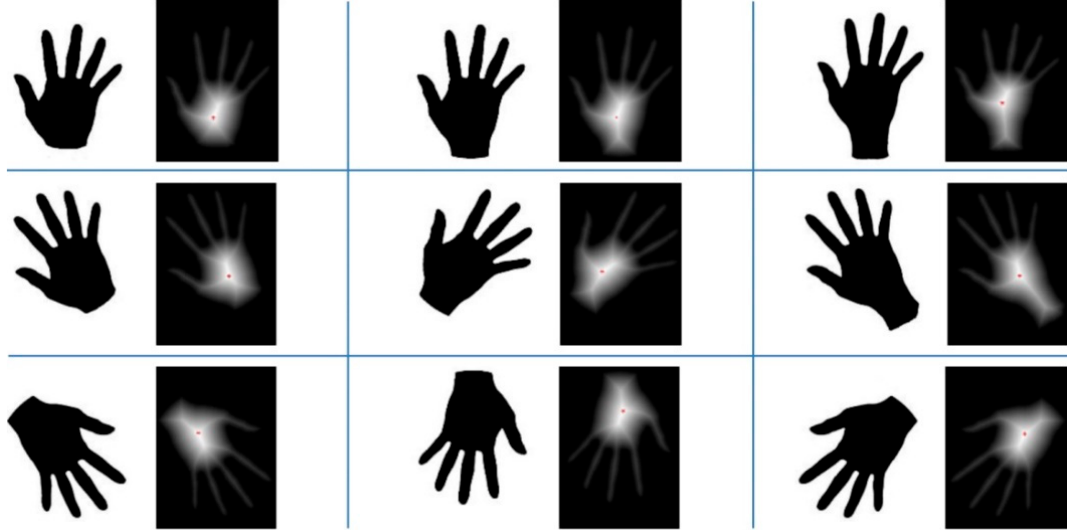
Figure 4. Fiducial points including fingertip and concave point extraction.